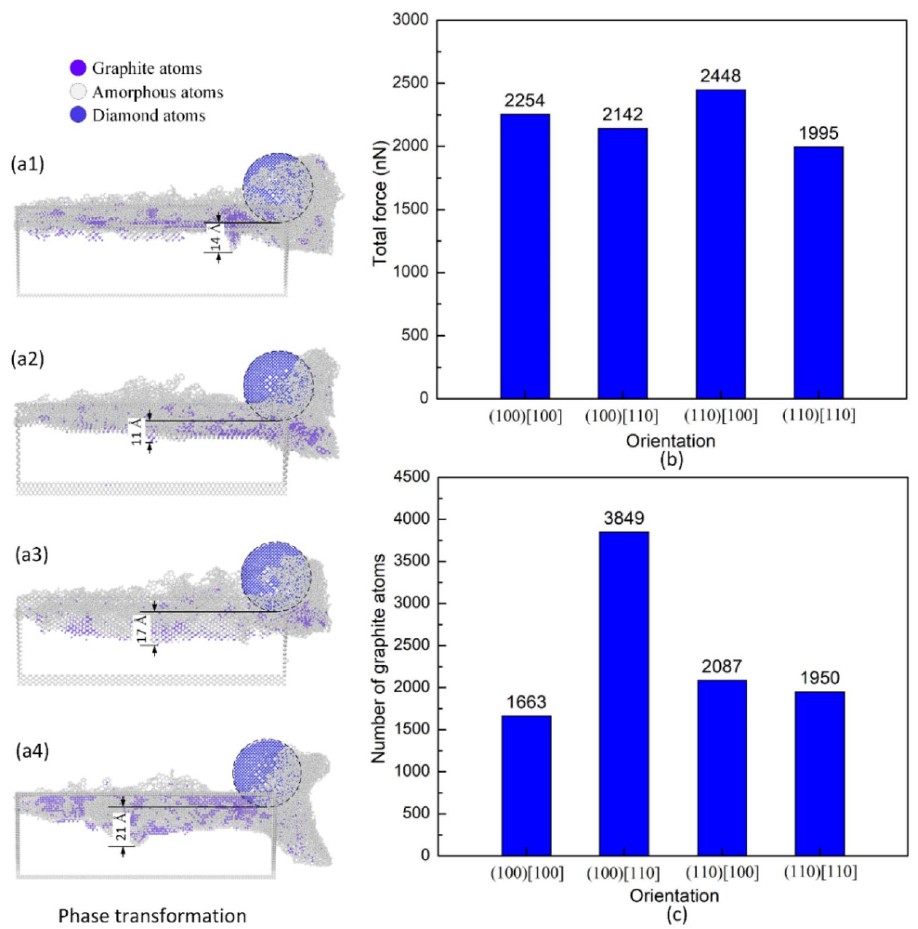
vs orientation; ( c ) number of graphite atoms vs